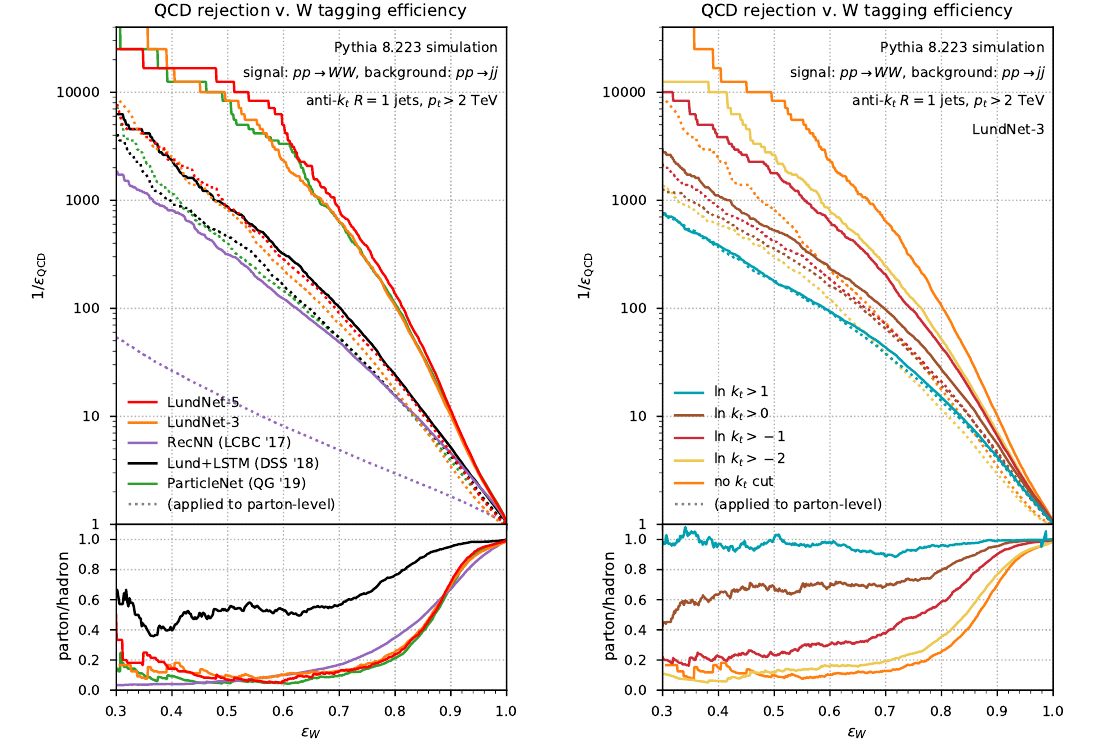
Figure 9 . Background rejection as a function of W tagging efficiency. Dotted lines indicate a W tagger applied on parton-level